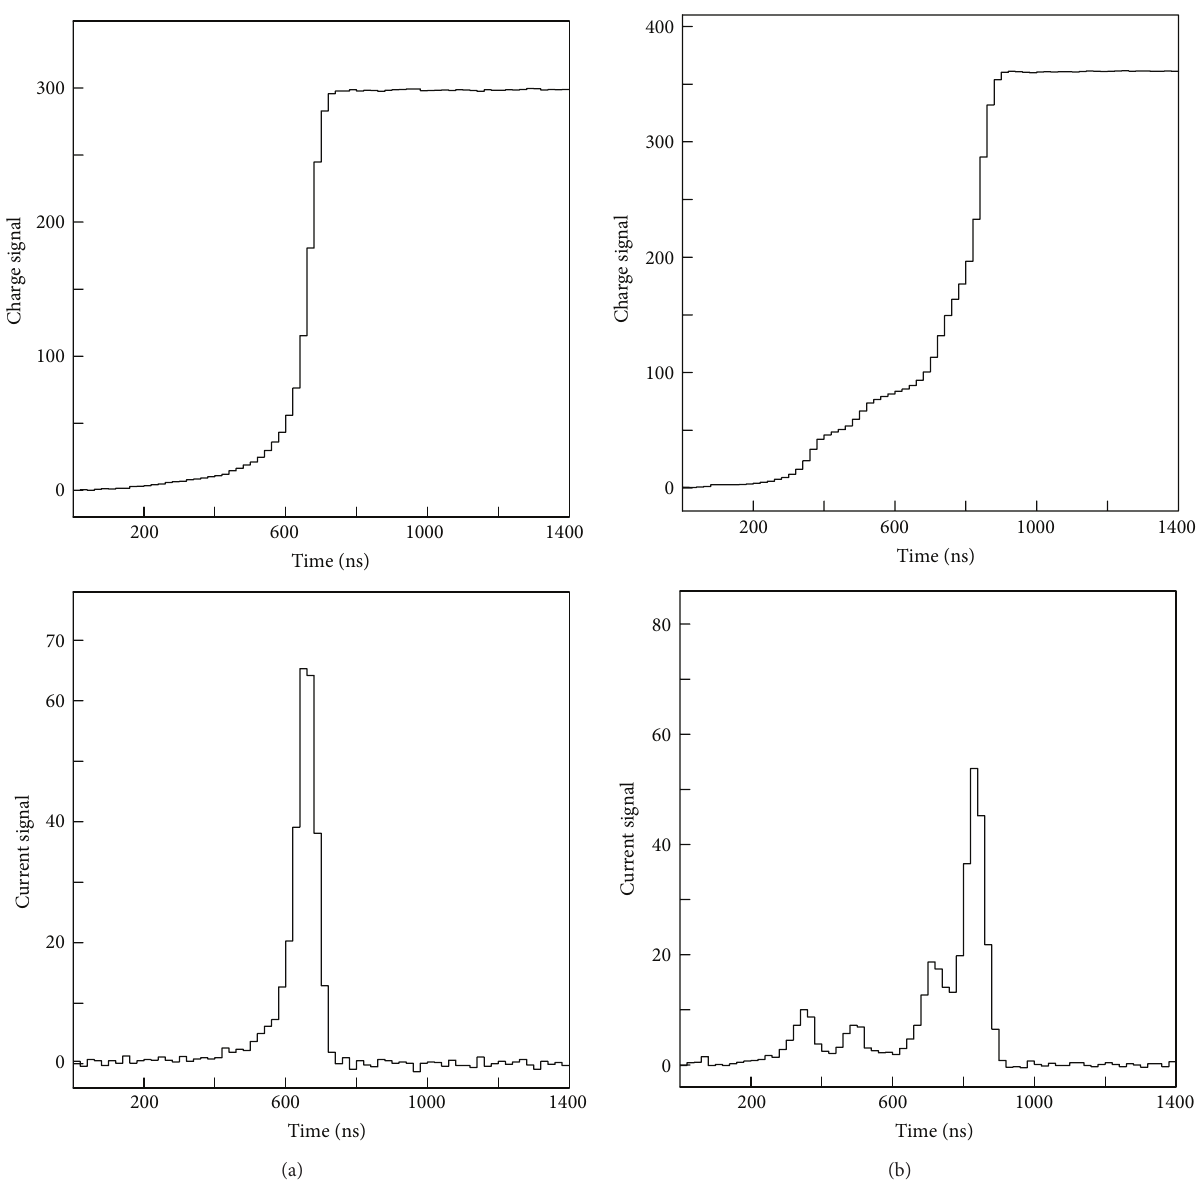
Figure 2: Current and charge pulse responses of a P-PC detector to single- and multisite 𝛾 -ray events. The pulse shapes in (a) show the charge (top) and current (bottom) signals resulting from a typical single-site interaction, while (b) shows how the pulse-shape response to a multisite interaction is clearly